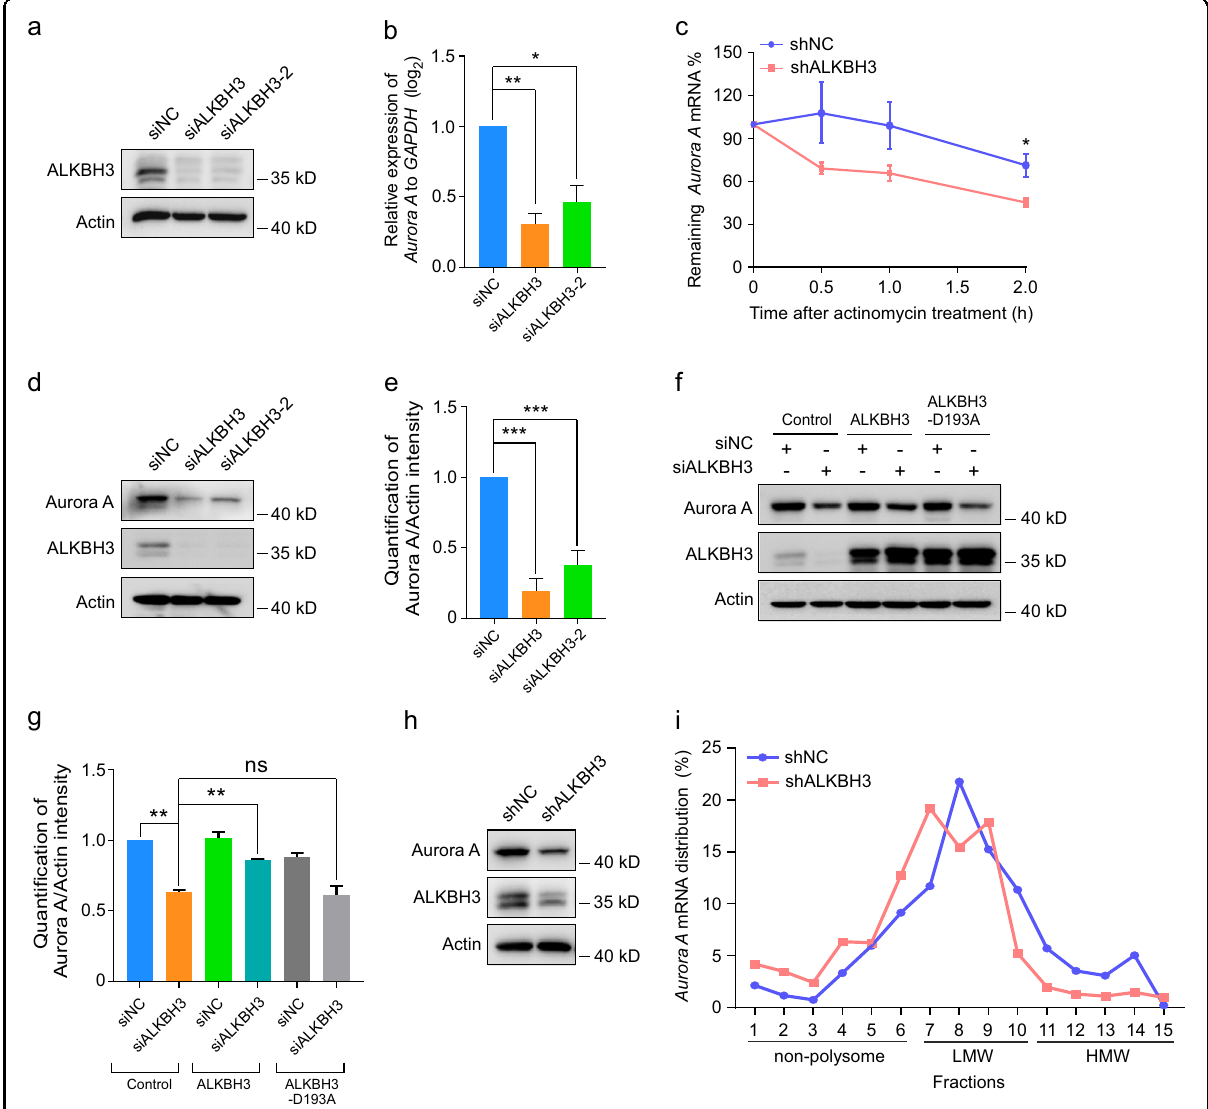
Fig. 3 Knockdown of ALKBH3 attenuates the stability and translation of Aurora A mRNA. a Western blotting analysis of ALKBH3 in RPE-1 cells treated with the indicated siRNAs. Actin was used as a loading control. b Quantitative real-time PCR (qRT-PCR) analysis of Aurora A in RPE-1 cells transfected with the indicated siRNAs. GAPDH was served as an internal control. c Quantitative RT-PCR of Aurora A mRNA in ALKBH3-depleted and control cells treated with actinomycin D (5 μ g/mL) at the indicated times. d – g Western blotting of Aurora A in RPE-1 cells transfected with the siRNAs or plasmids as shown. Actin, a loading control. The intensity of Aurora A was measured based on the normalization to Actin. h Western blotting analysis of ALKBH3 and Aurora A in RPE-1 cells infected with lentivirus carrying shRNA targeting ALKBH3. Actin was used as a loading control. NC, negative control. i Polysome pro fi ling of Aurora A mRNA in cells infected with lentivirus carrying shRNA targeting ALKBH3 after sucrose gradient centrifugation. Data are shown as the means± SD from at least three independent experiments. Student ’ s t- test; ns, not signi fi cant; * P <0.05, ** P < 0.01, *** P